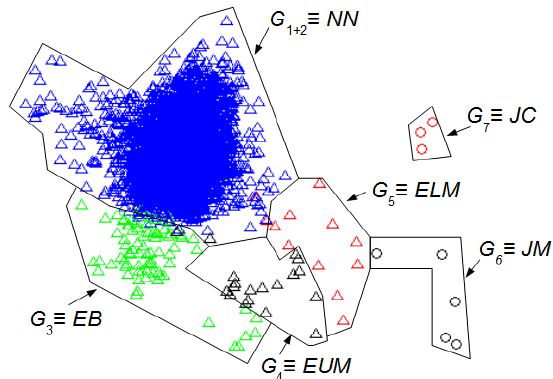
Figure 5. Groups of intervals found using the supervised classification (SM) [8] and the first two